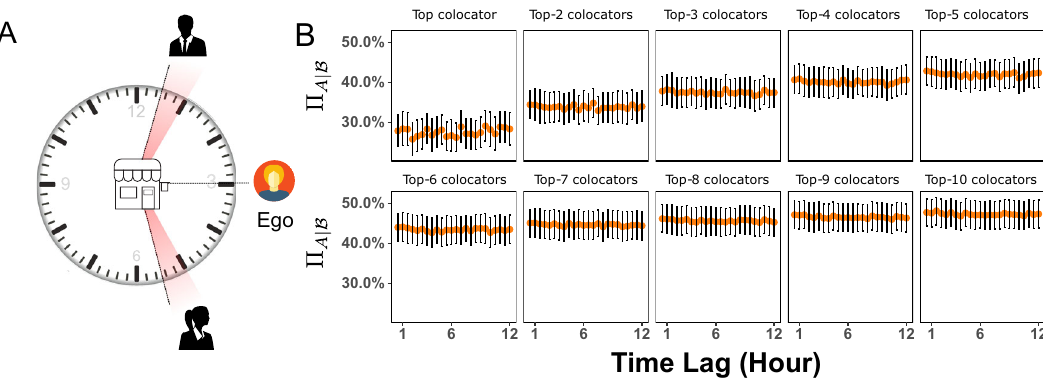
Fig. 6 Temporal stability of non-social colocator(s) information. A An example of two time-displaced colocators who visit the same location as the ego on a T = 2.5 h time lag. (Vector Clip-art designed by https://www.freepik.com.) B The (cumulative) cross-predictability in fl uence of temporal-lag for non- social colocator(s) in Weeplaces. Each point corresponds to a colocation network resulting from the amount of temporal offset between an ego and alters visit to a common location. Error bars denote